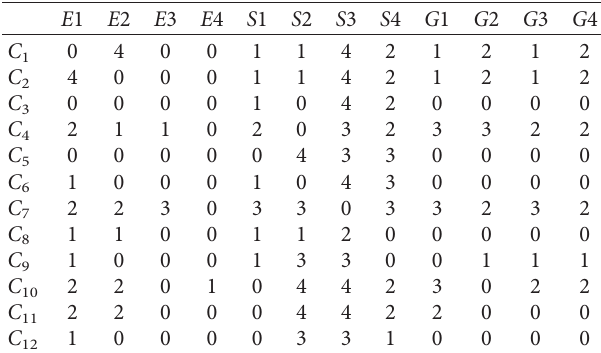
Table 27: Comparison matrix of linguistic variable of sustainability criteria in deterministic condition.